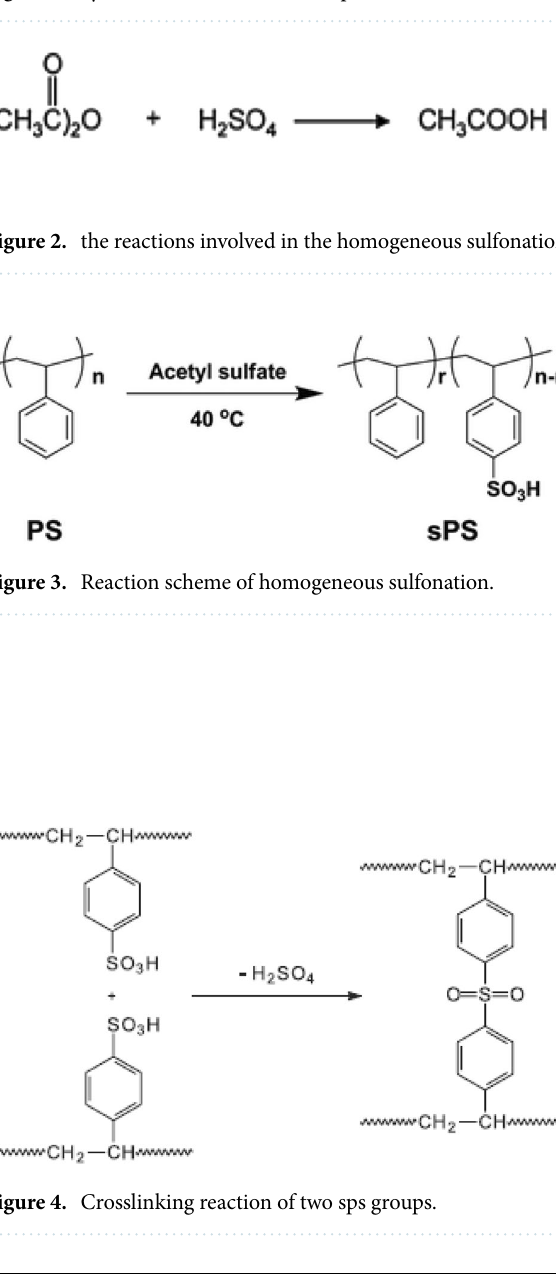
Figure 1. Synthesis of GO + SWPS composites.